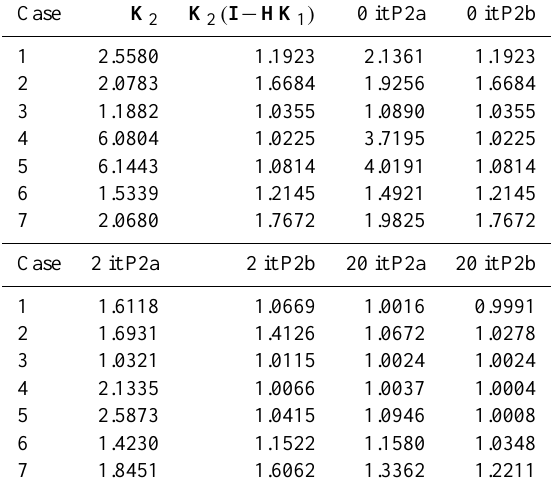
Table C2. Average error for different analysis formulations of pro- cess 2. As in Table C1, column 5 of the upper part gives the same result as column 3, as it should. The average relative error variance is based on 100000 independent realizations.